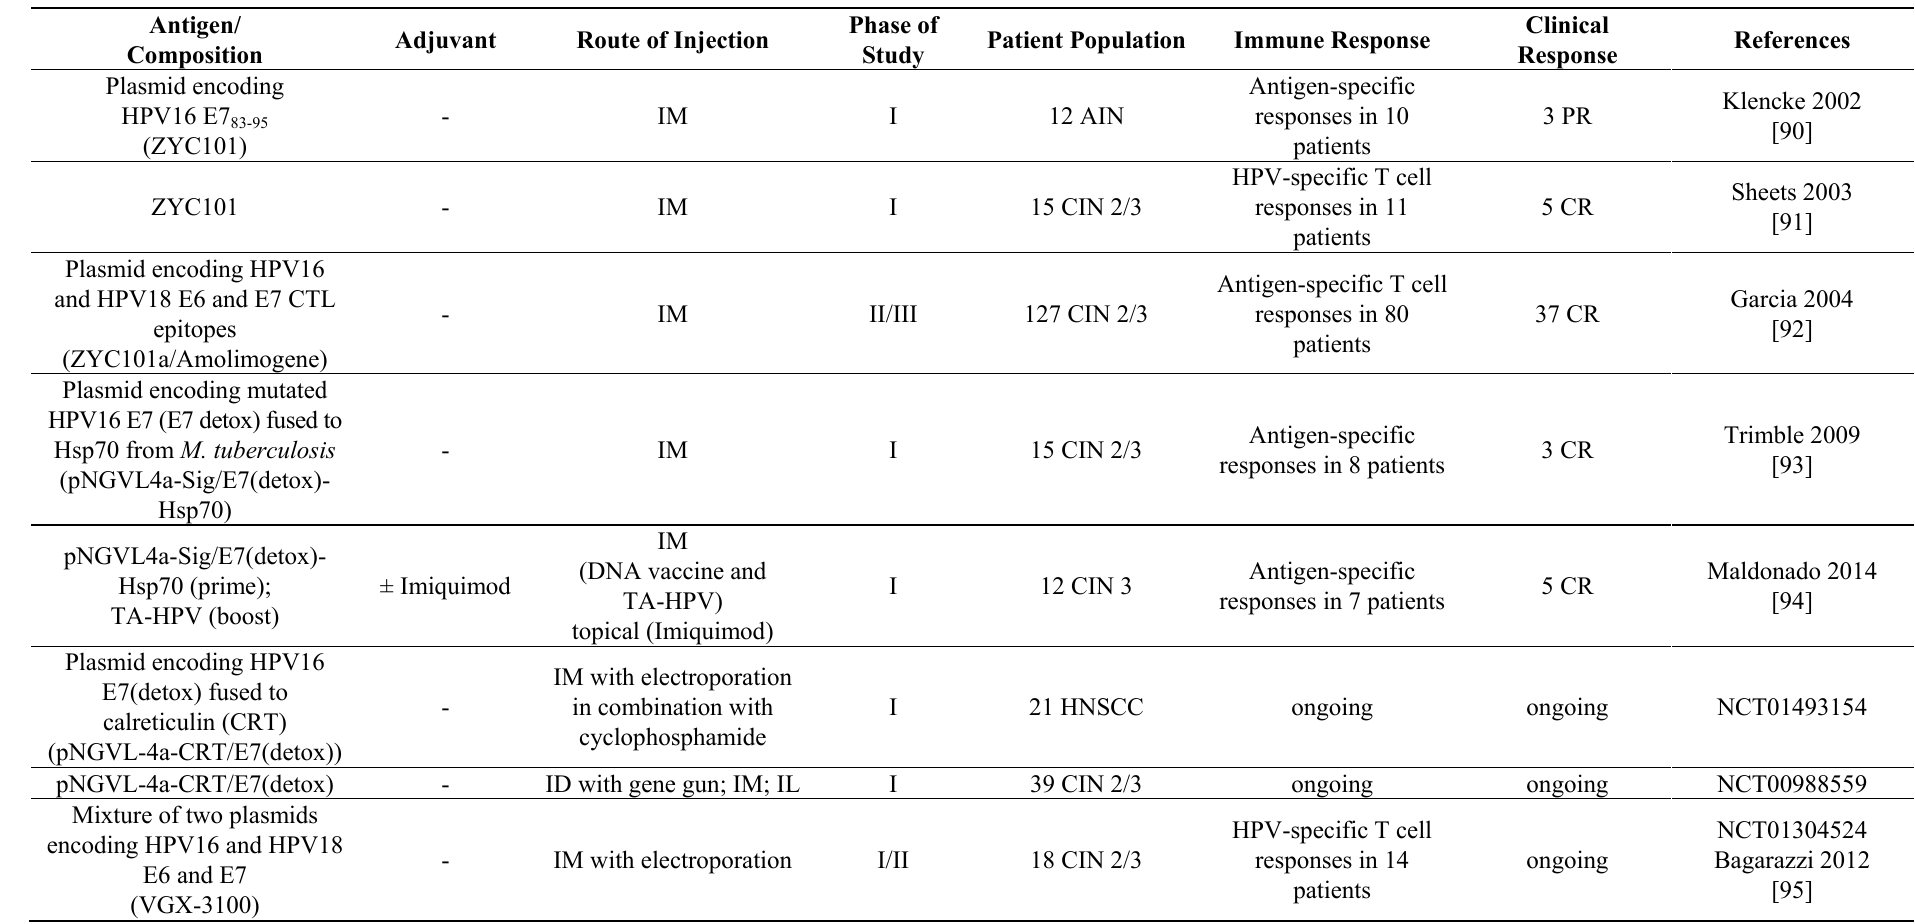
Table 3. Clinical studies with DNA